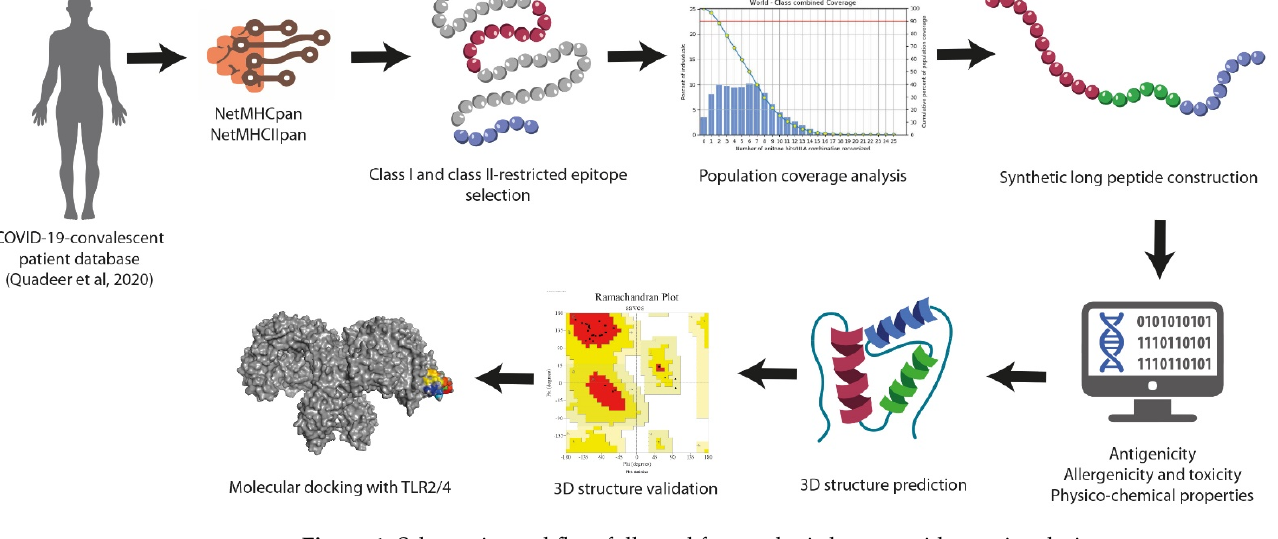
Figure 1. Schematic workflow followed for synthetic long peptide vaccine design.